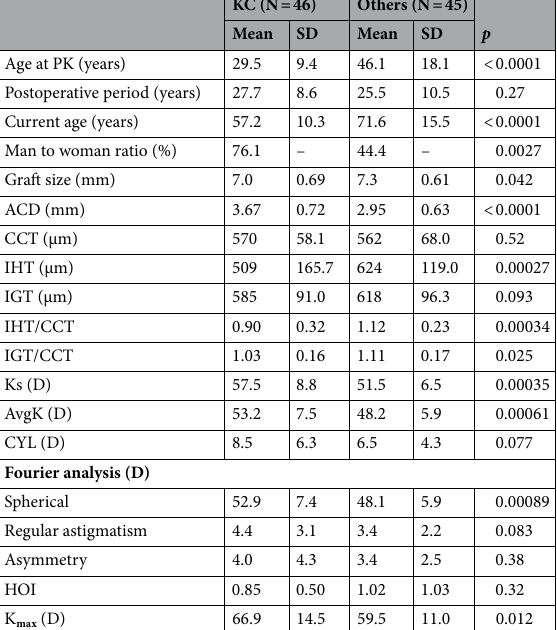
Pearson correlation coefficients revealed interesting differences between the KC and Others groups. First, positive correlations between the graft size and corneal thinning parameters observed in the KC group were not observed in the Others group. Graft size was also negatively correlated with keratometric parameters in the KC group, but not in the Others group. In other words, a smaller graft may cause more thinning and more severe protrusion, i.e., KC progression. Second, negative correlations between corneal thinning parameters and keratometric parameters were observed in the KC group, but not in the Others group. This suggests that inferior corneal thinning is related to stronger keratometric values, and thus those parameters are reliable for evaluating KC progression after PK. Positive correlations between ACD and keratometic parameters were common to both groups, indicating that eyes with a deeper ACD tend to have a stronger corneal power regardless of the primary indications for PK. This supports the rationale for using ACD as a corneal protrusion parameter, although ACD sometimes depends on cataract formation. As described above, the corneal ectasia parameters that we set (IHT/CCT, IGT/CCT, and ACD) can prob- ably be used as indicators of KC progression after PK. Next, we performed multivariant regression analysis to determine the risk factors for KC progression. From the examined candidate risk factors (age at PK, current age,